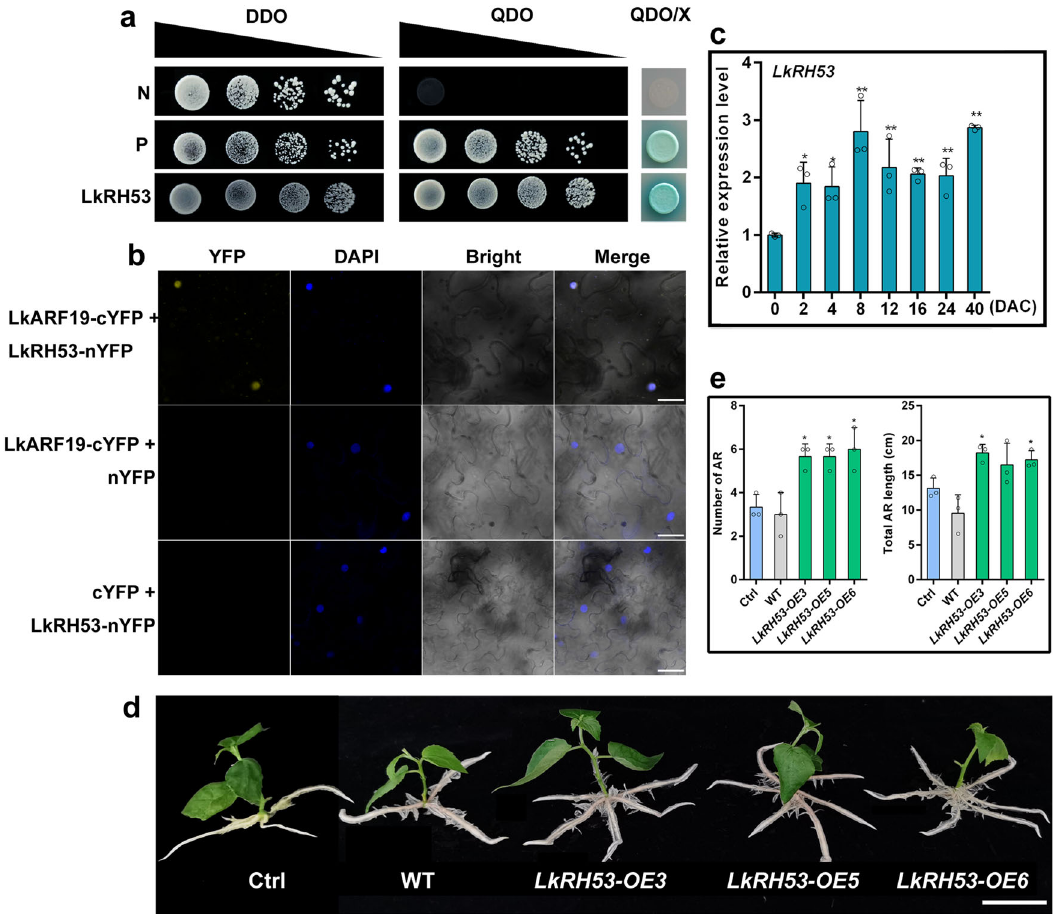
Fig. 6 Interaction between LkARF19 and LkRH53. a Yeast two-hybrid analysis of interaction between LkARF19 and LkRH53. N, negative control (pGBKT7- LamC + pGADT7-LargeT); P, positive control (pGBKT7-p53 + pGADT7-LargeT); LkRH53 (pGBKT7-LkARF19 + pGADT7-LkRH53). DDO, SD/-Trp-Leu; QDO, SD/-Trp-Leu-His-Ade; QDO/X, SD/-Trp-Leu-His-Ade + X- α -gal. b Bimolecular fl uorescence complementation assay analysis of interaction between LkARF19 and LkRH53. LkARF19-cYFP + nYFP and cYFP + LkRH53-nYFP were used as negative controls. Scale bars, 30 μ m. c qRT-PCR analysis of LkRH53 in the basal stem sections (0.5 cm) during cutting propagation. DAC, days after cutting. The value on DAC 0 was set to 1. d Overexpression of LkRH53 promoted AR formation in 84 K poplar. Scale bars, 3 cm. e Average AR number and total AR length of the control plants, WT, and overexpression lines in 2- week-old seedlings. Error bars represent standard deviations from three biological replicates; *P < 0.05 and **P < 0.01, t